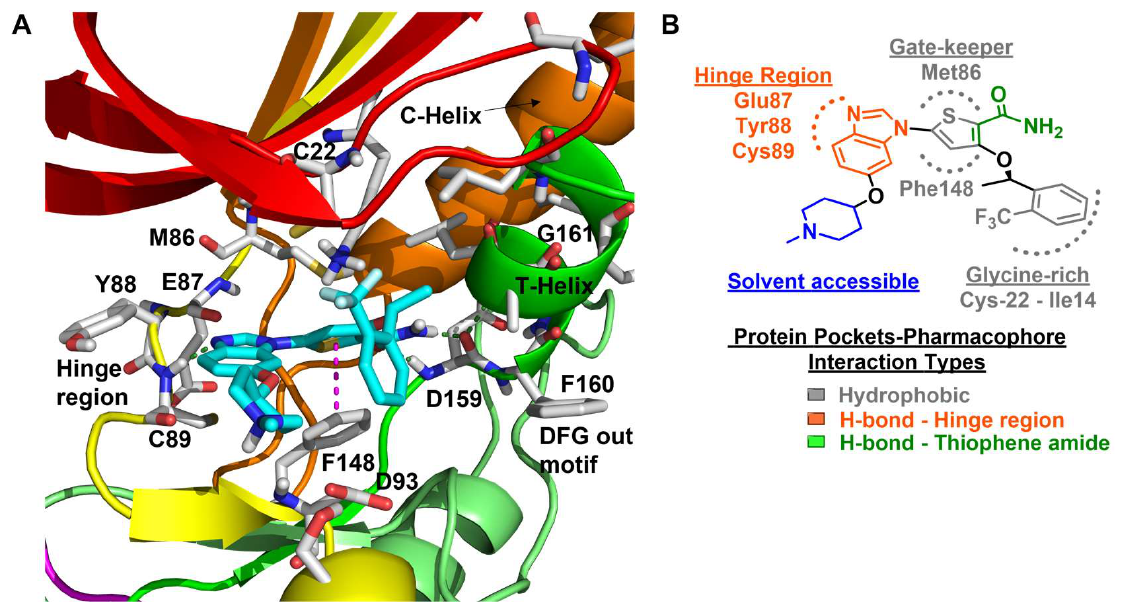
Figure 9. ( A ) Crystal structure of rac-1 bound inactive Nek2 that adopts a DFG-out conformation. Key protein residues and region that interact with the inhibitor have been designated. All polar interactions are depicted by green dotted lines, whereas non-polar interactions are presented as purple dashed lines. (PDB code: 2XNM) ( B ) Schematic representation of rac-1-bound Nek2 with color-coded interactions.